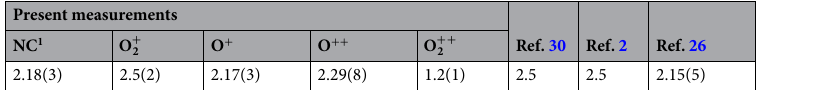
Present measurements